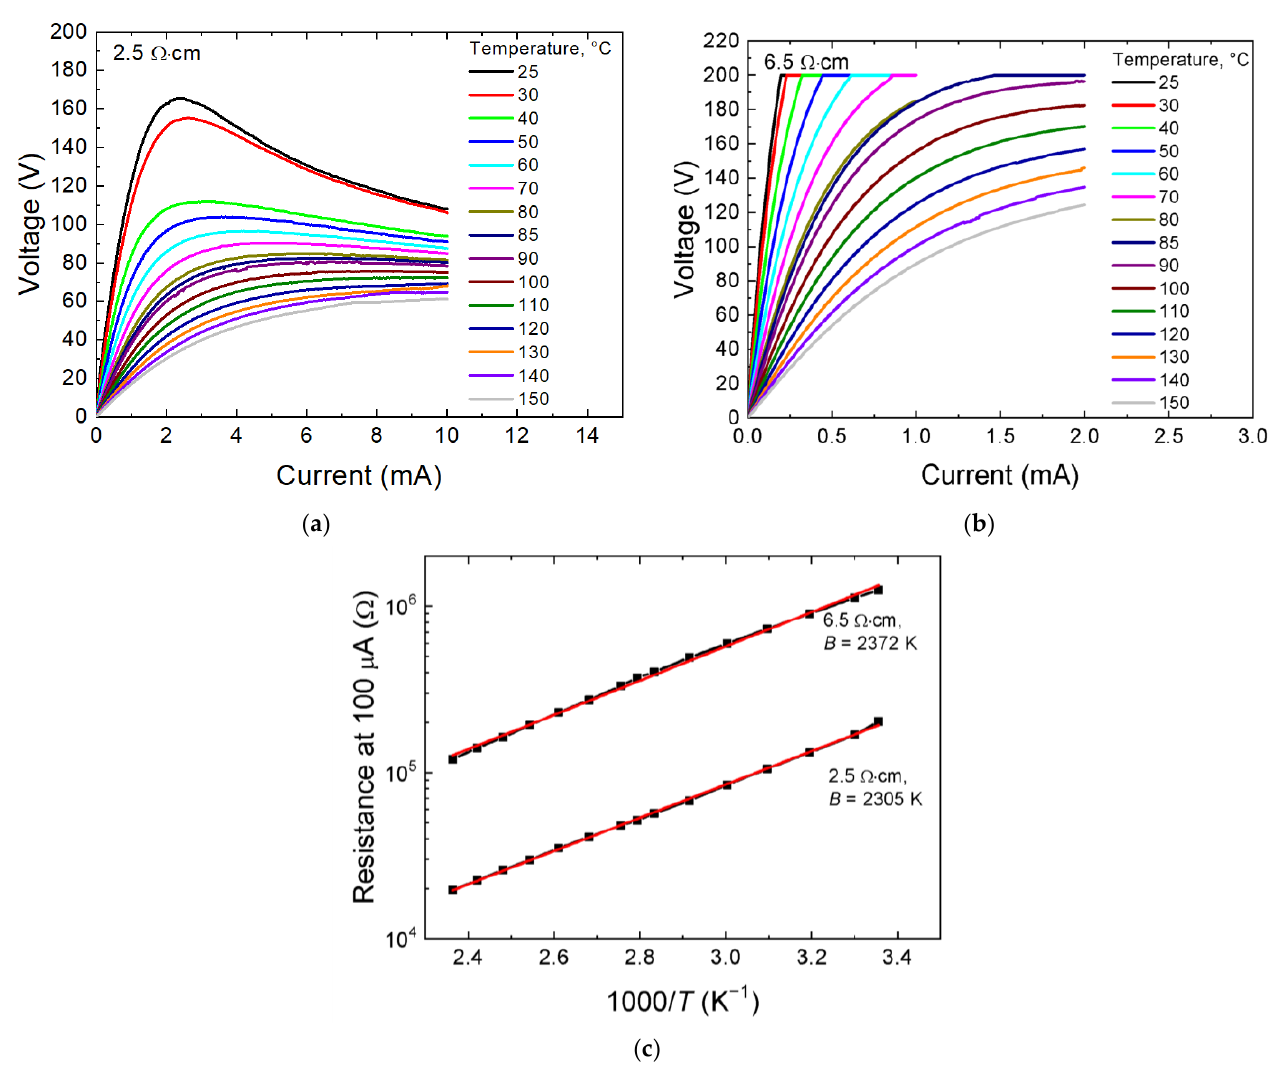
Figure 3. I – V characteristics at different measurement temperatures of the films obtained from ce- ramics 2.5 ( a ) and 6.5 Ω∙cm ( b ); (c) the dependence of resistance in logarithmic scale on the recip- ceramics 2.5 ( a ) and 6.5 Ω · cm ( b ); ( c ) the dependence of resistance in logarithmic scale on the rocal temperature. reciprocal